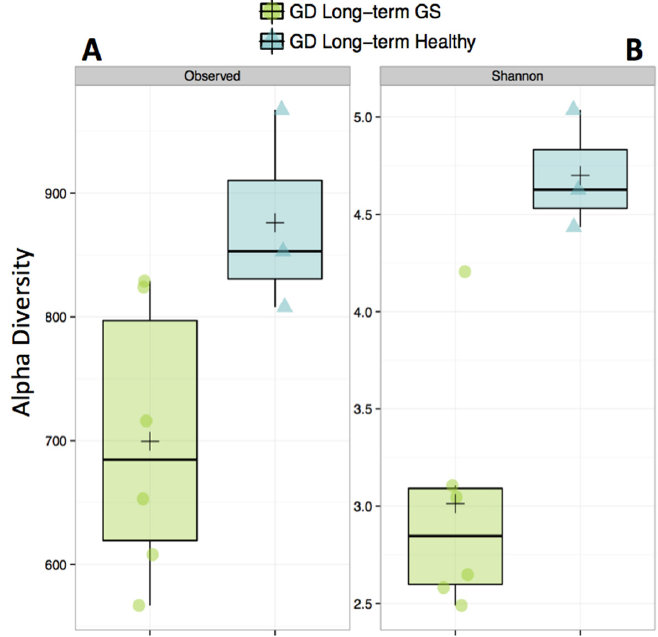
Figure 1. Alpha ‐ diversity of the gut microbiome is decreased in gluten ‐ sensitive (GS) macaques. Observed ( A ) corresponds to total number of Operational Taxonomic Units (OTUs) present in sample; Shannon, ( B ) corresponds to Shannon Diversity Index that accounts for both the abundance and evenness of OTUs. Green color represents GS juvenile macaques on GD (long ‐ term) diet while blue indicates age ‐ and gluten ‐ containing diet (GD) diet ‐ matched healthy controls.